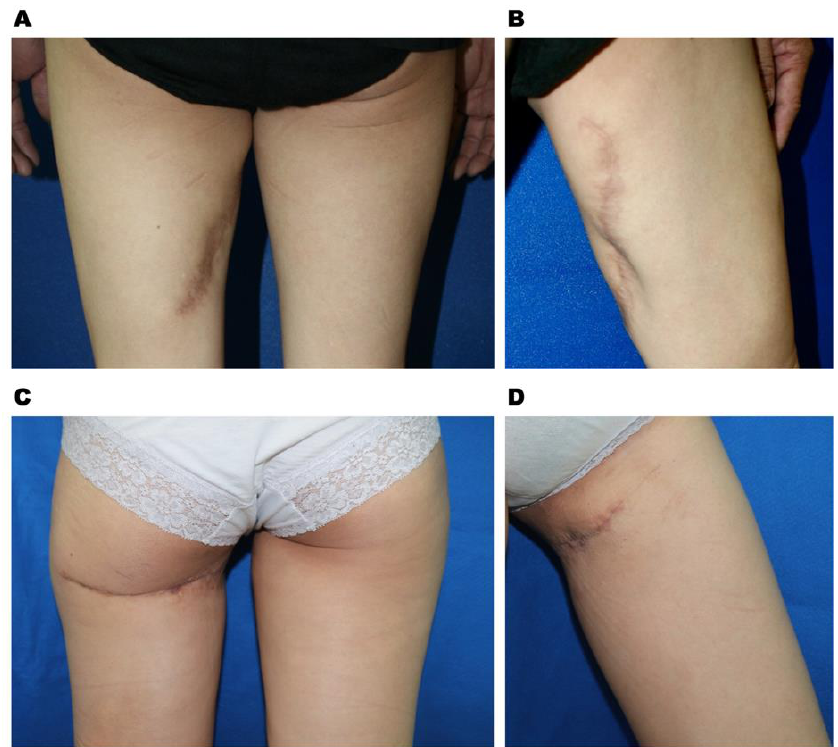
Figure 2. Donor site appearance after a PAP flap is harvested with a vertical flap design in the posterior ( A ) and anterior medial ( B ) view at follow-up session at 22 months and with transverse flap design in posterior ( C ) and anterior medial ( D ) view at follow-up session at 21 months.